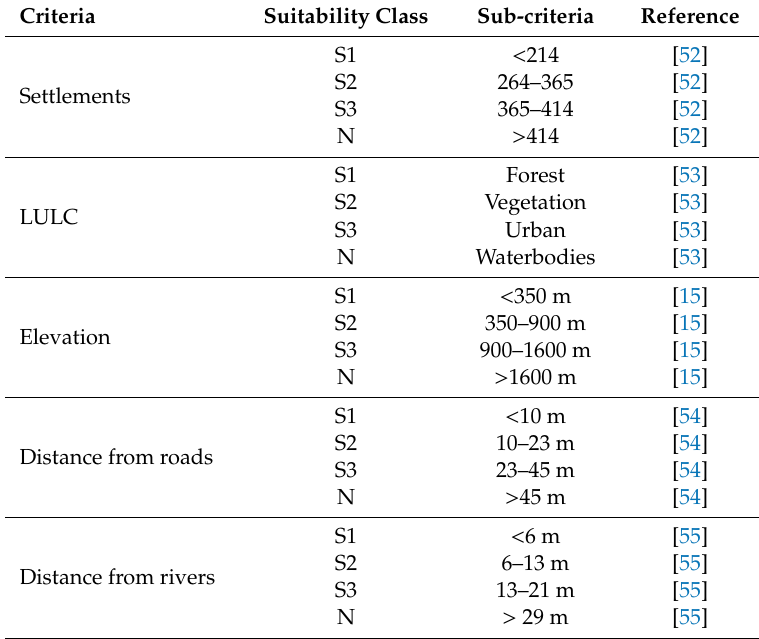
Table 3. Criteria of the land suitability analysis for the extension of forest